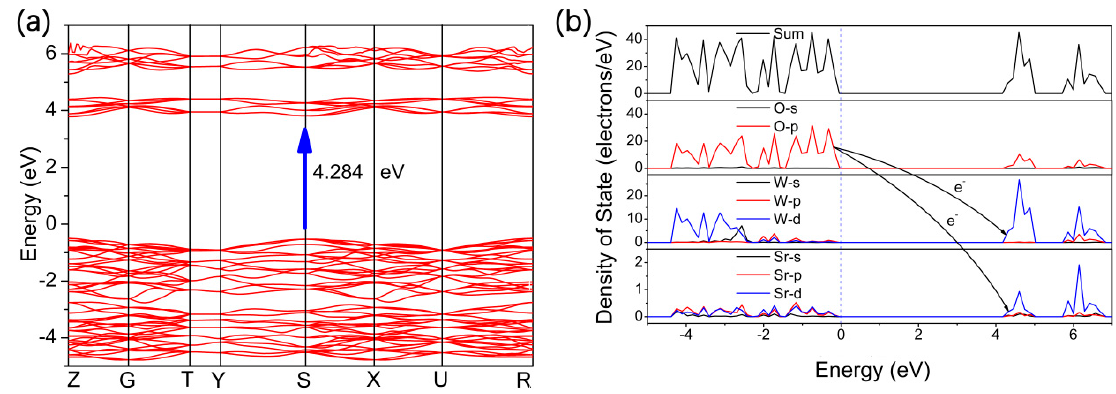
Figure 11. Theoretical calculations band structure and density of states for SrWO 4 .